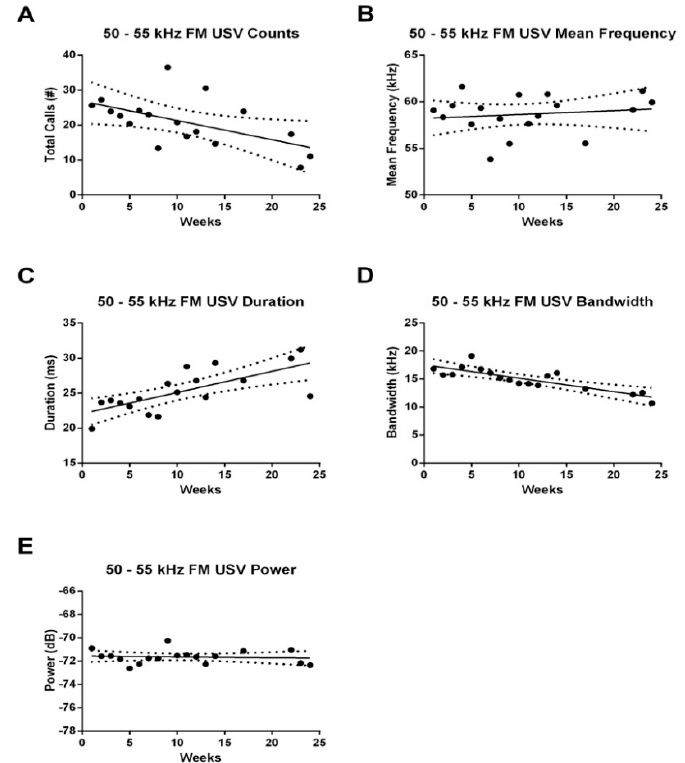
Figure 3. Correlation between age and 50–55 kHz FM USV counts and acoustic characteristics during the 4-h recording period. ( A ) There was a significant reduction in total 50–55 kHz FM USV counts as the animals aged ( p < 0.05). ( B ) Mean frequency of 50–55 kHz FM USVs did not vary with age. There was an increase in ( C ) duration, and decrease in ( D ) bandwidth with age. ( E ) Power did not vary with age. Dots represent the group average across all control rats during each of the recording weeks.